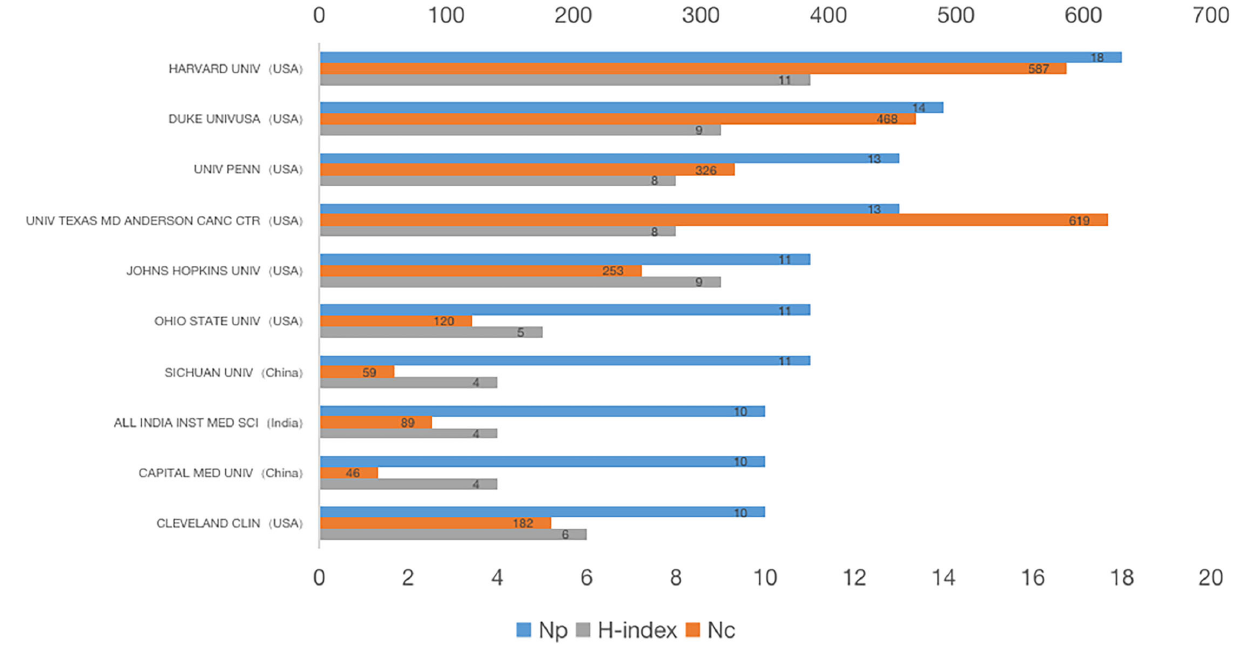
FIGURE 5 | Total publications, H-index, and the total citation of top 10 institutes.